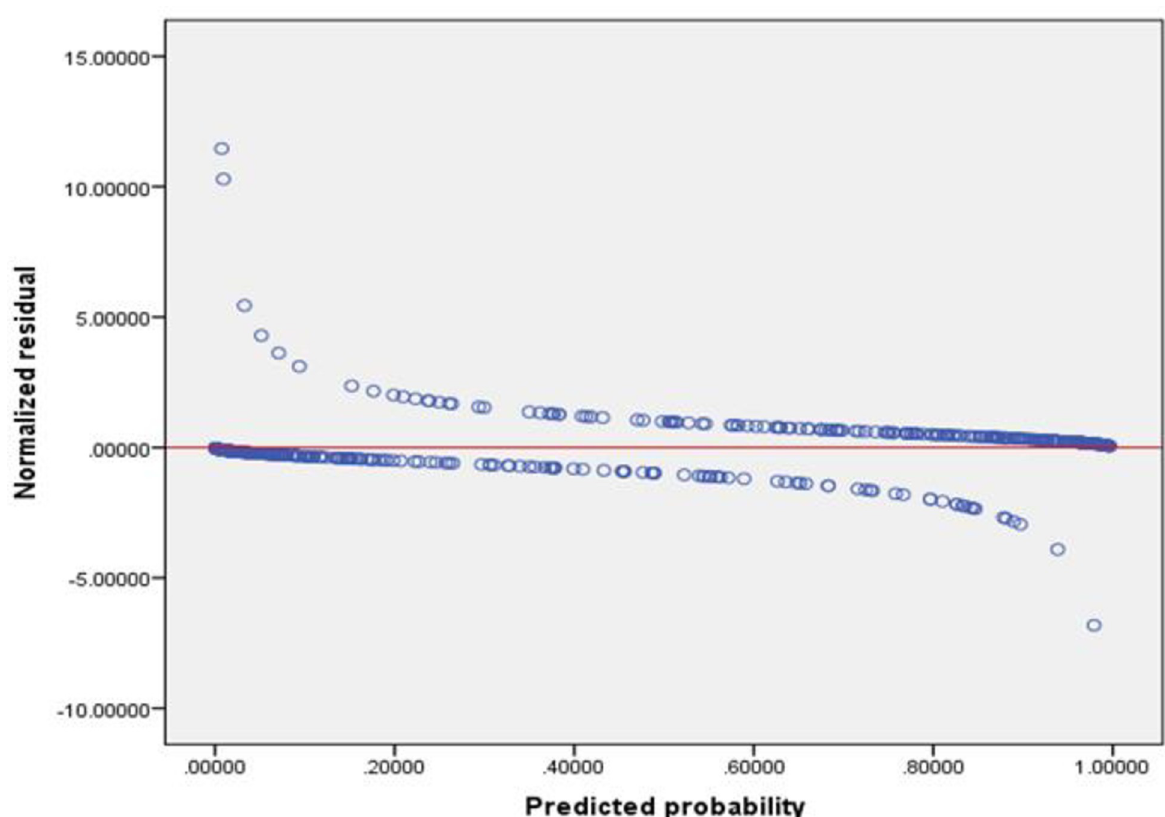
Fig 3. Residual versus predicted probability plot for the fitted